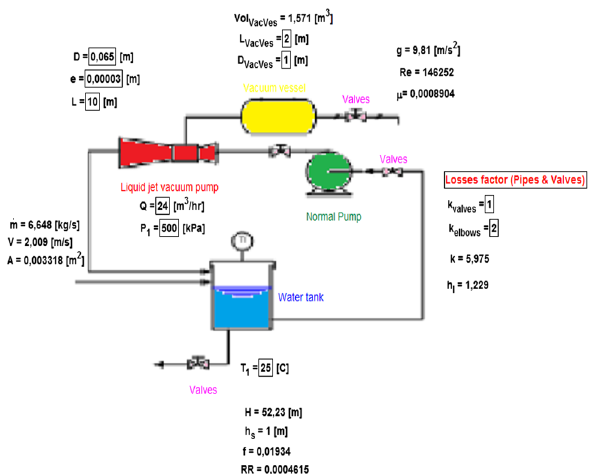
Fig. 15 Interface of the EES program for the vacuum system